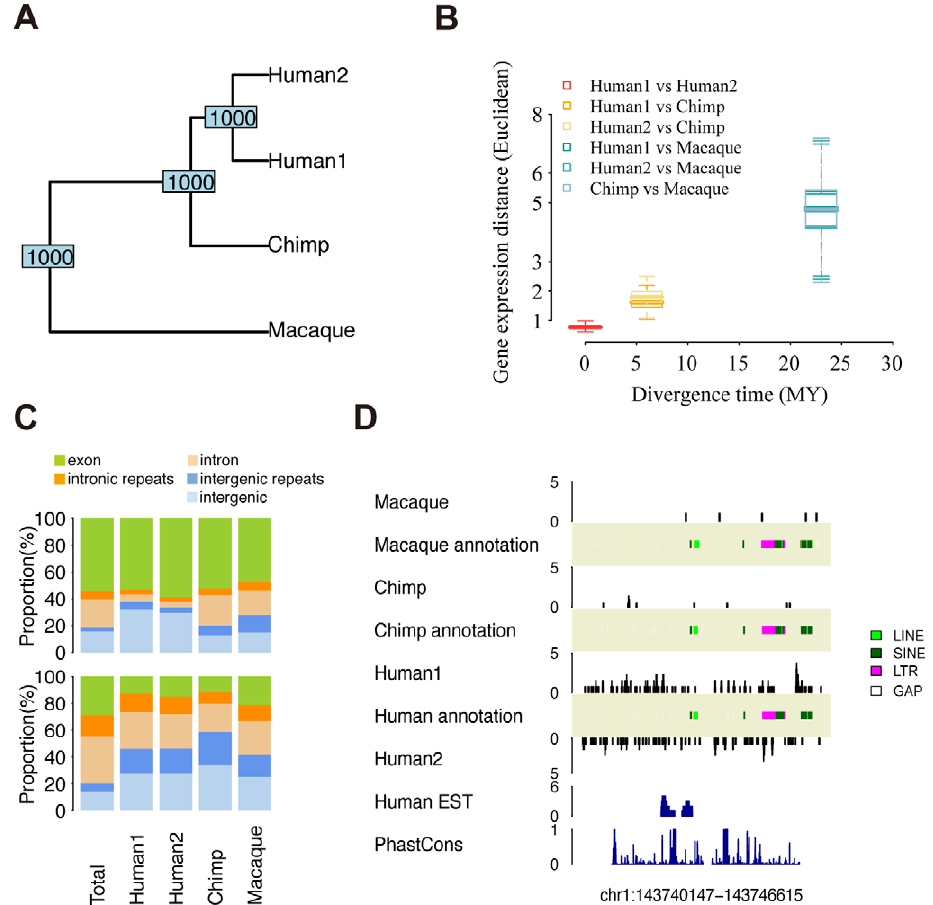
Figure 3. Transcription divergences. (A) UPGMA tree based on the expression level of 13,832 genes in 4 sample pools. The numbers at the nodes indicate node stability in 1,000 bootstraps over genes. (B) The gene expression divergence between sample pairs plotted against the species divergence time. The box plot represents variation of the divergence estimated from 1,000 bootstraps over genes (same set of genes as (A), see Materials and Methods). (C) The upper panels show genomic annotation of nucleotides covered by at least one sequence read within all HTR identified in at least one sample (Total) and HTR with species-specific expression. Genomic locations of species-specific HTR are listed in Table S8. The lower panels show genomic annotation of nucleotides covered by at least one sequence read within all genomic windows (Total) and genomic windows with species-specific expression. Locations of species-specific genomic windows are listed in Table S10. The colors represent: exons (green), intronic repeats (orange), introns (light orange), intergenic repeats (blue), and intergenic regions (light blue). (D) An example of a genomic window with human-specific expression.